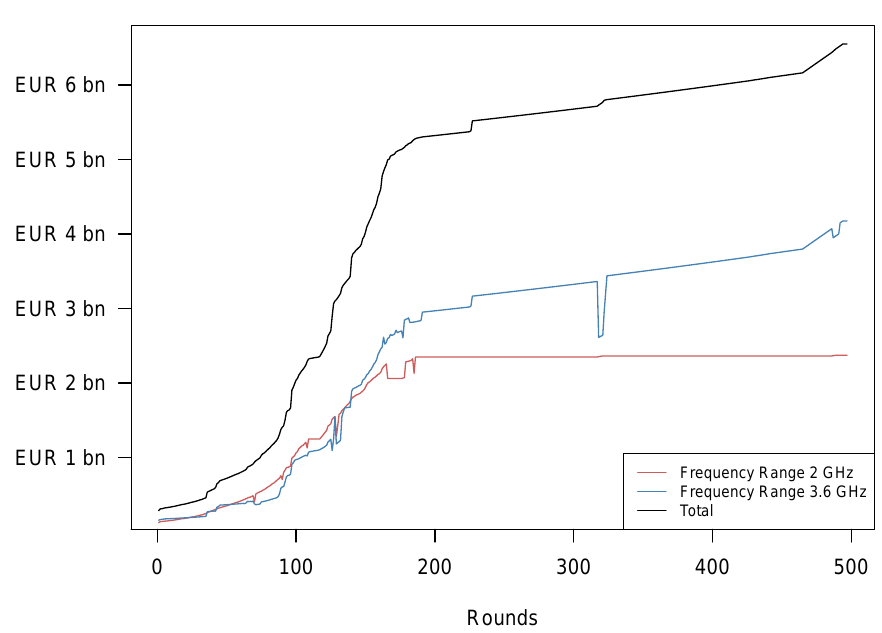
Figure 1. Evolution of the Sum of Bids . The graph illustrates the development of the sum of submitted bids for the entire auction and for each individual frequency band. Withdrawn high bids still had to be paid, which is why a reduction of an individual band’s sum of bids does not affect the overall revenue of the